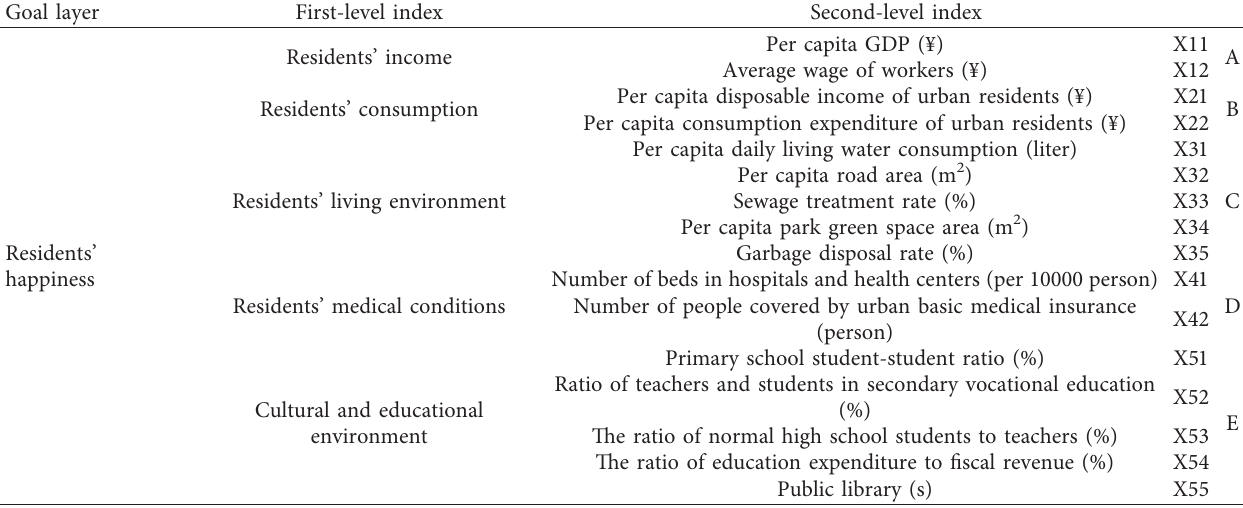
Table 1: Evaluation index system of residents’